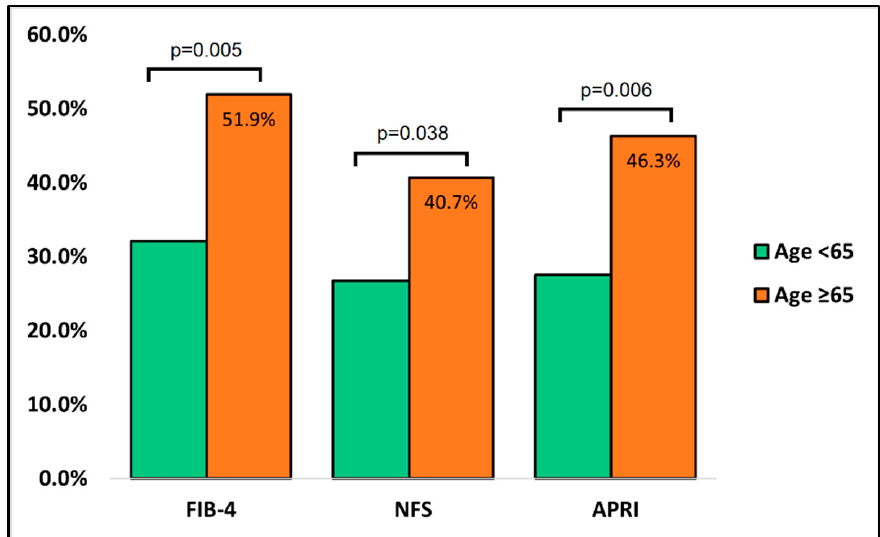
Figure 3. Comparison of liver fibrosis scores between survivors and deceased cases at admission.